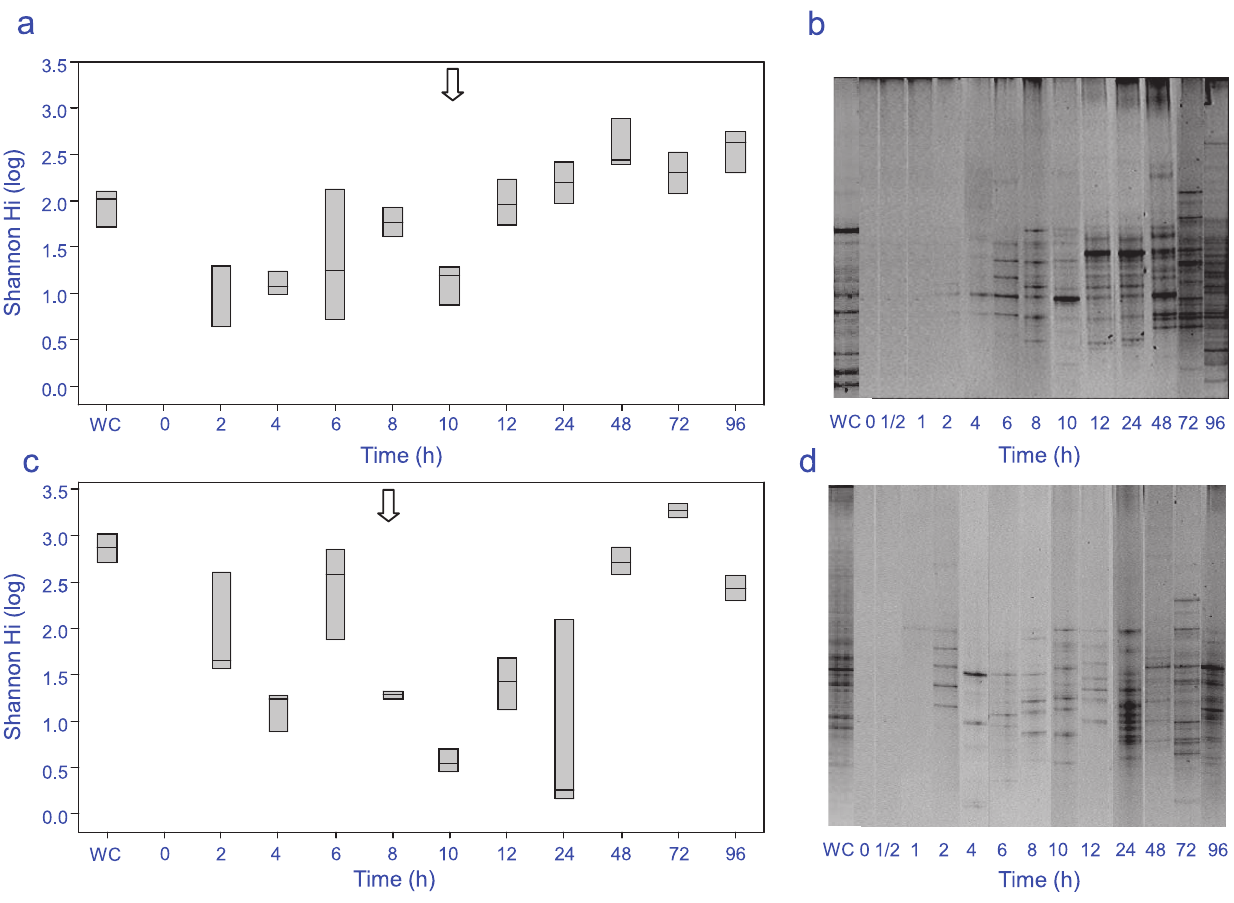
Figure 4. Shannon-Weiner diversity based on DGGE composite (a) Box-plots of the winter season (August 2008), (b) DGGE composite image (winter), (c) box plot of summer season (March 2009), (d) DGGE composite image (summer). Arrow depicts storm event with increased chop (winds above 35 km/h). Average wind speed for other sample periods was below 20 km/h. WC = water column.